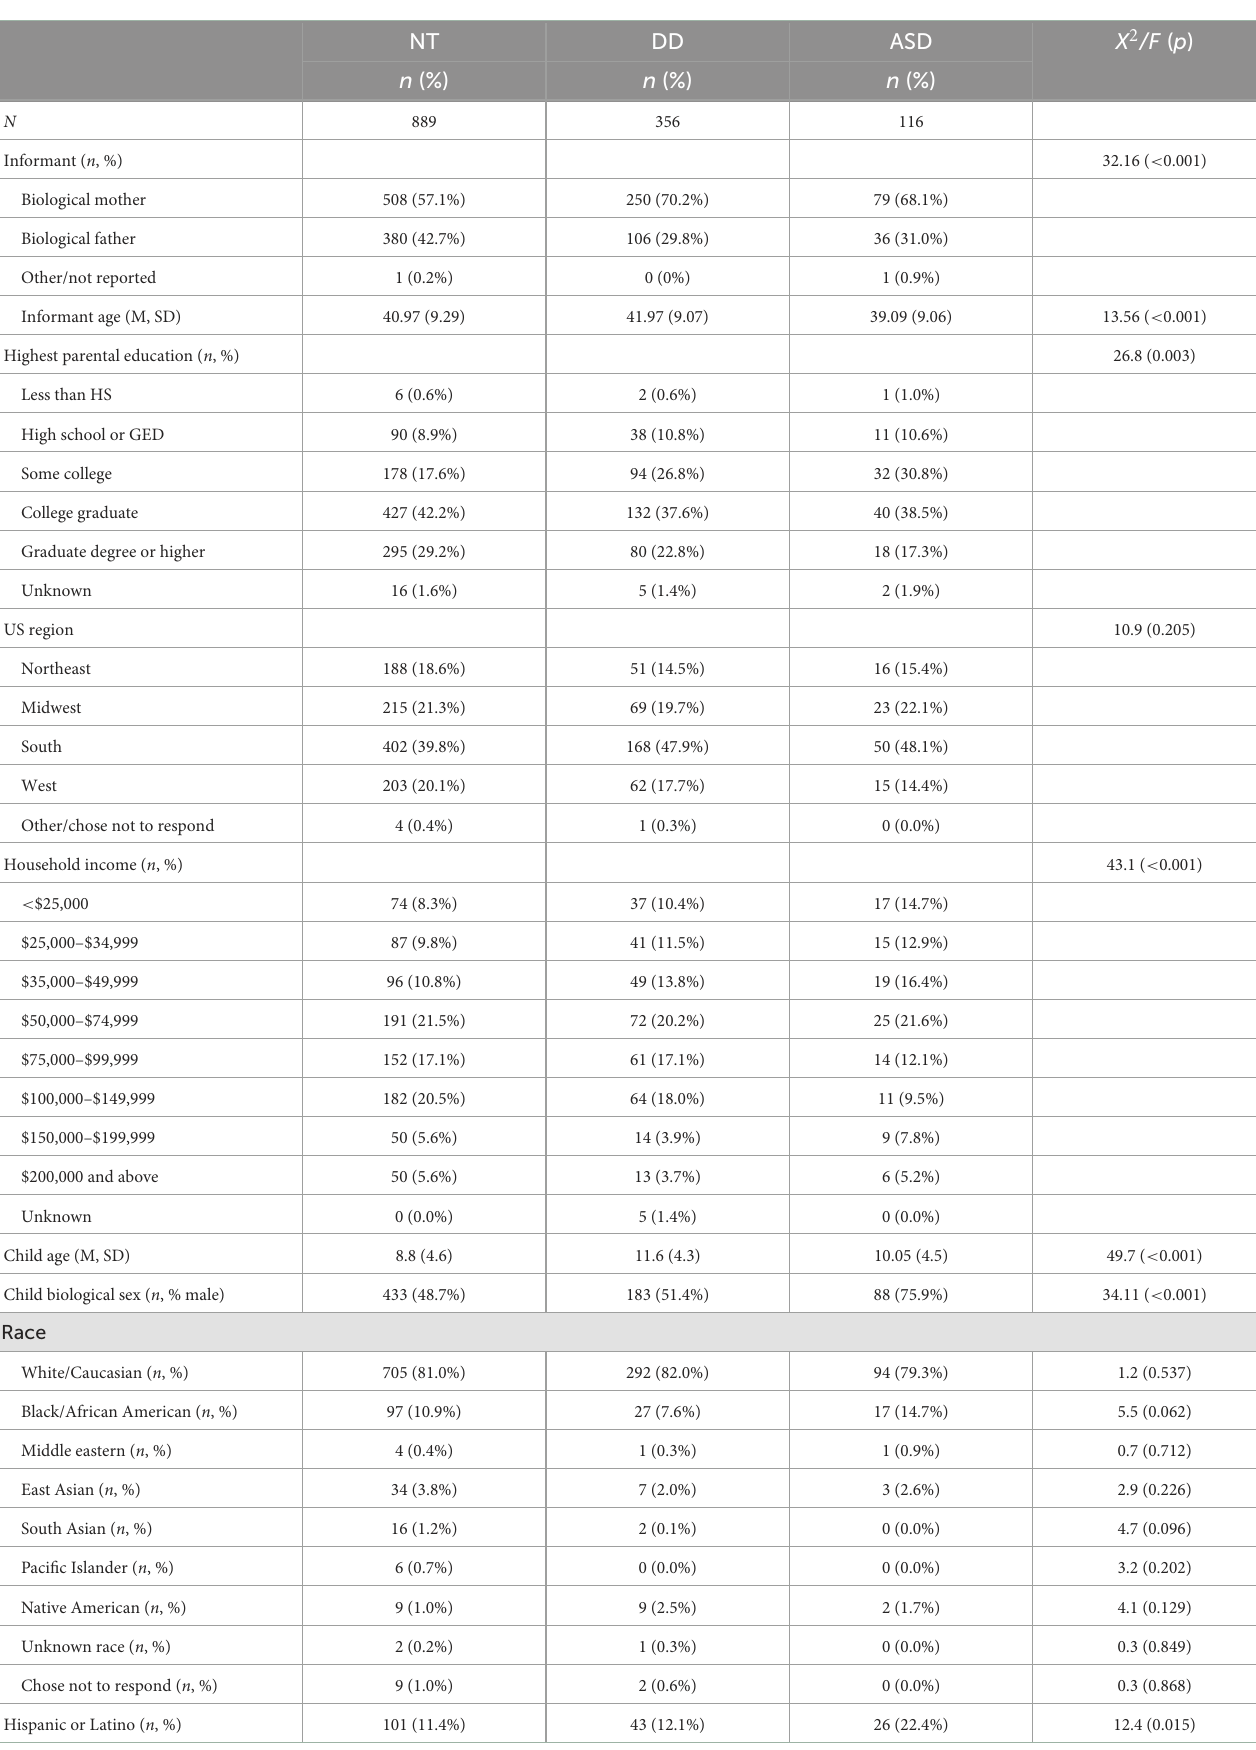
TABLE 1 Demographic and clinical characteristics across autism spectrum disorder (ASD), developmental disability (DD), and neurotypical (NT)